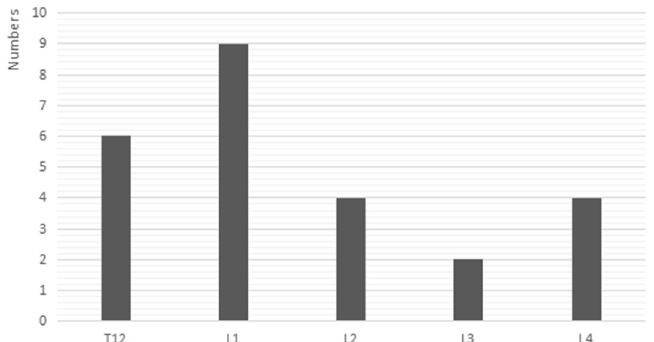
Figure 2. Distribution of the injured